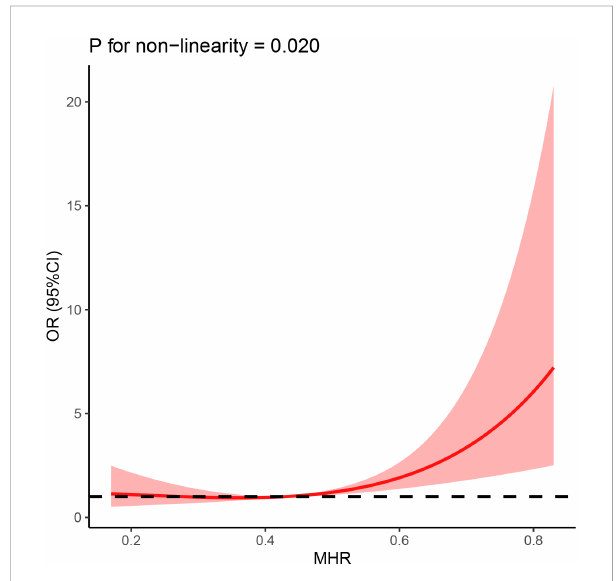
FIGURE 4 The association between MHR and AF was shown using restricted cubic splines (RCS), adjusting for age, sex, BMI, hypertension, diabetes mellitus, Coronary heart disease and smoking